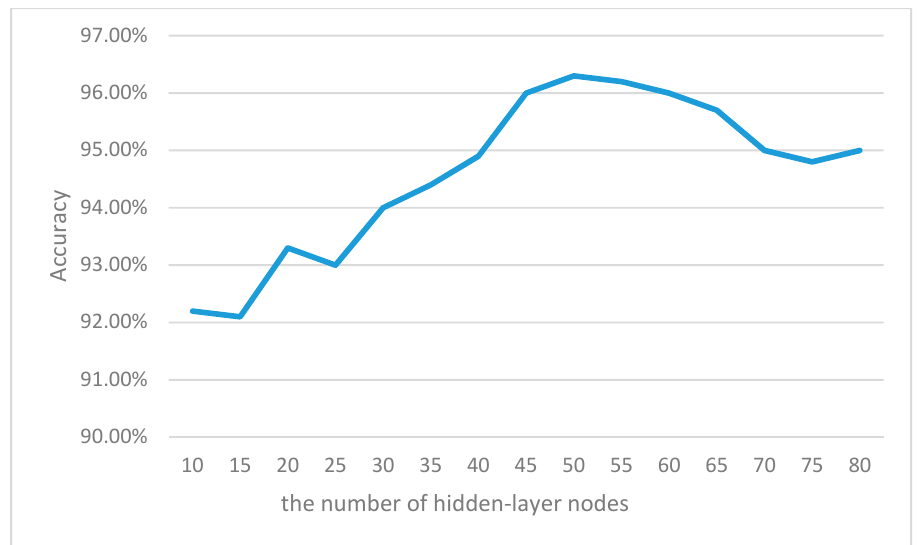
Figure 10. Accuracy of cross-validation test with different hidden-nodes numbers.